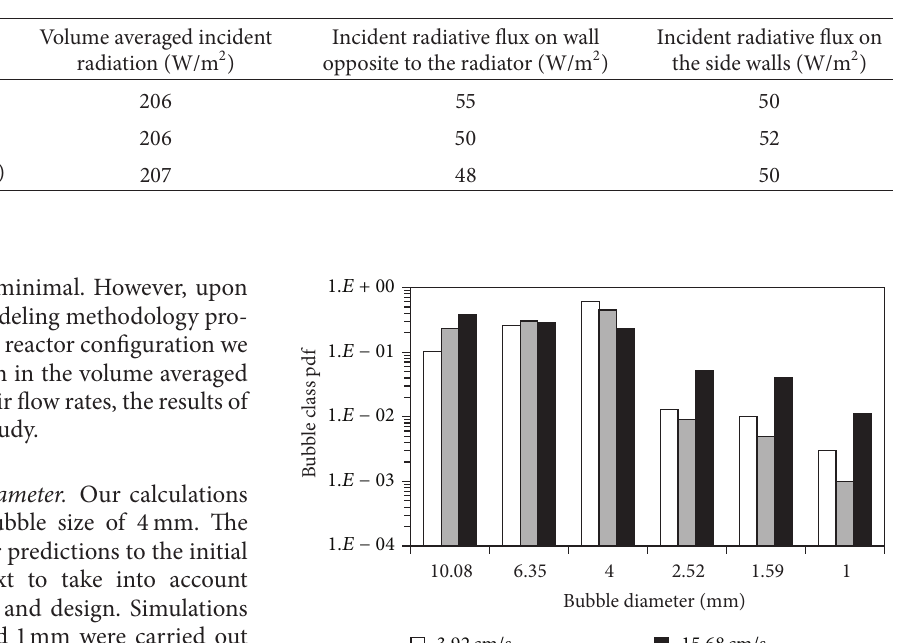
Table 3: Sensitivity of radiative transfer predictions to the inlet gas velocities in the simulations carried out with the TFM + population balance approach and initial bubble diameter of 4 mm.